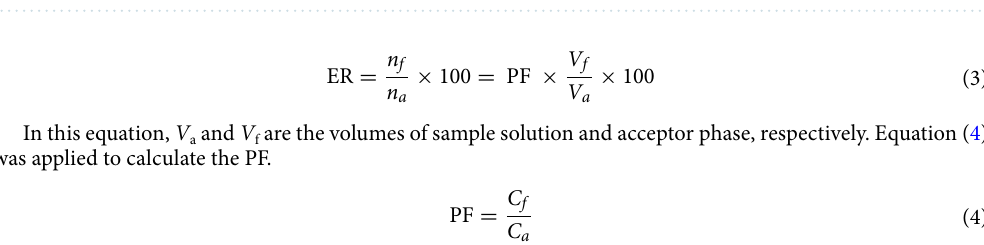
Figure 1. ( a ) SEM image, ( b ) X-ray diffraction pattern, and ( c ) EDX spectrum of